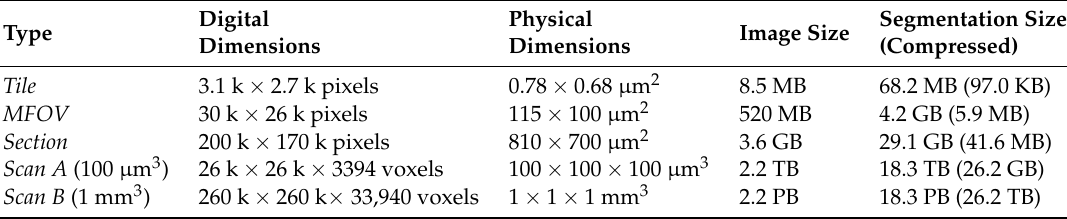
Table 1. Our electron microscopy data form a hierarchy of different types and dimensions. Multiple image tiles are acquired at nanometer resolution as an MFOV, and then stitched in sections. Thousands of sections are stacked into a scan. There is a large difference between image data and segmentation data due to the 64 bit encodings required to represent potentially billions of neurons. For segmentation data, we report average compression rates of 700 × using the Compresso scheme [45]. For images, we assume a resolution of 4 × 4 × 30 nm 3 per voxel and 8 bit encoding. The Butterfly middleware and its applications have been tested on Scan A (100 µ m 3 ), acquired using the Zeiss MultiSEM 505 electron microscope. Scan B is yet to be acquired using the same